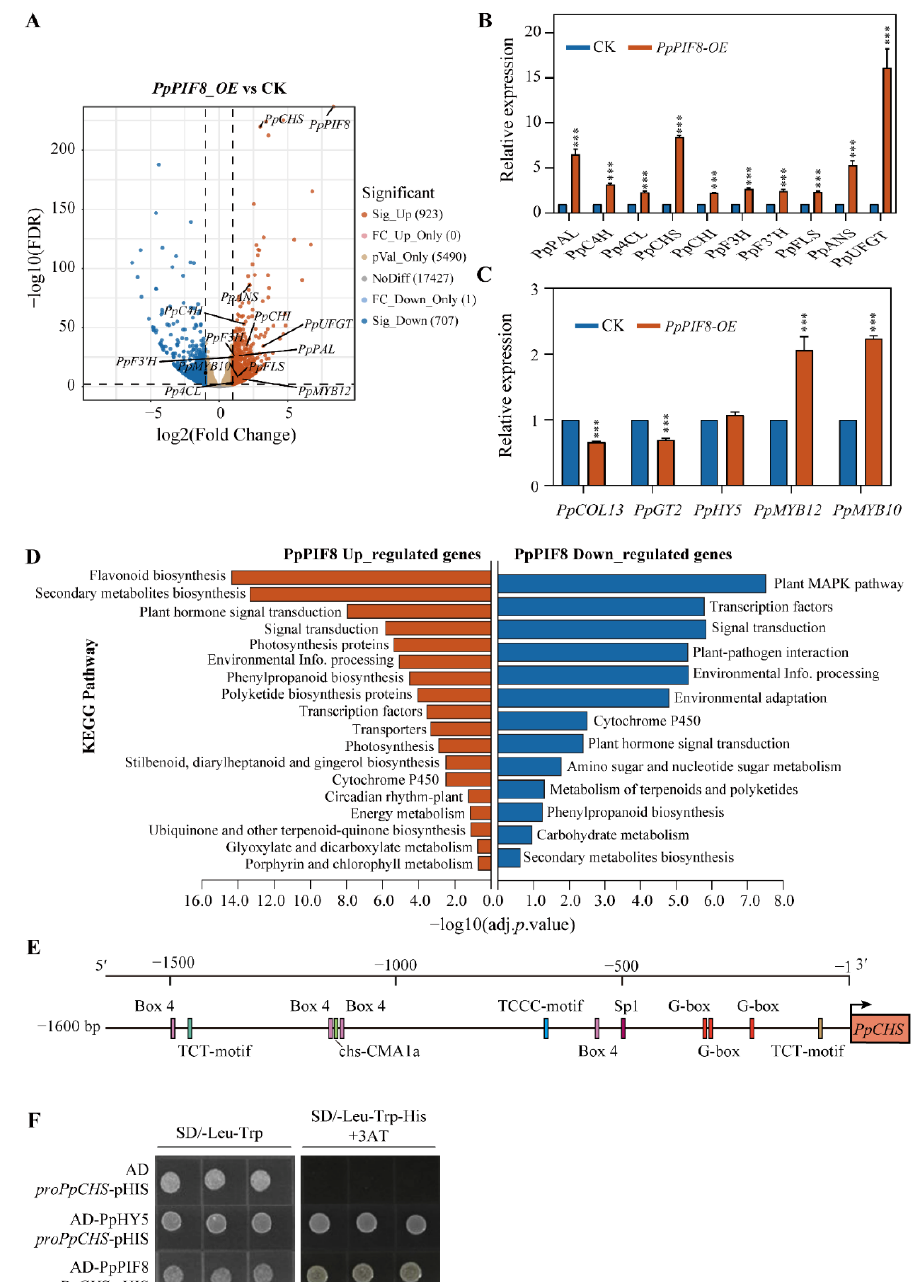
Figure 11. RNA-Seq analysis of PpPIF8_OE transgenic pear calli. ( A ) A volcano plot illustrating DEGs between PpPIF8_OE and control pear calli. Genes significantly upregulated and downregulated in PpPIF8_OE pear calli are shown in red and blue, respectively. ( B ) Validation of anthocyanin biosynthesis genes expression by RT-qPCR. Error bars denote the standard deviation. Asterisks above the bars indicate significant differences (*** p < 0.001, * p < 0.05) obtained by two-tailed Student’s t -test. ( C ) Validation of transcription factor expression by RT-qPCR. Error bars denote the standard deviation. Asterisks above the bars indicate significant differences (*** p < 0.001, * p < 0.05) obtained by two-tailed Student’s t -test. ( D ) KEGG pathway analysis of upregulated and downregulated genes in PpPIF8_OE pear calli. ( E ) Promoter analysis of PpCHS . ( F ) Yeast one-hybrid analysis of the interaction between PpPIF8 and the PpCHS promoter. SD/ − Leu − Trp, synthetic dextrose medium lacking Leu and Trp; SD/ − Leu − Trp − His+3AT, synthetic dextrose medium lacking Leu, Trp, and His plus 5 mM 3AT.